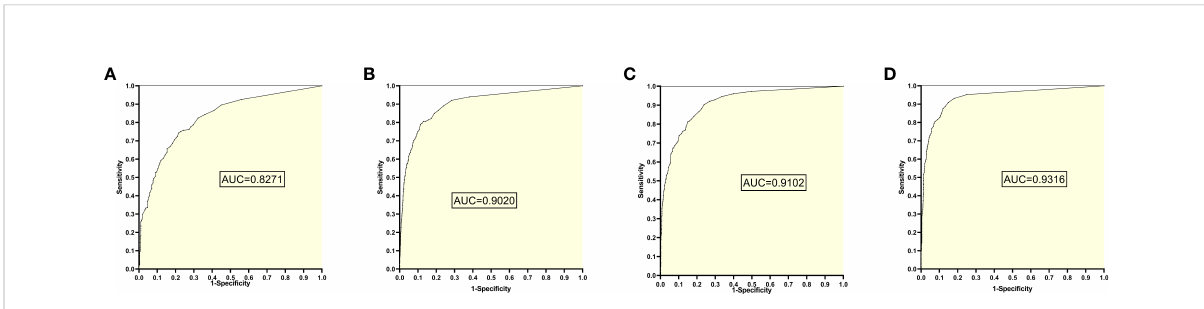
FIGURE 5 ROC curves and AUC values obtained from the training set 4 model testing each test set: (A) results from test set 1; (B) results from test set 2; (C) results from test set 3; (D) results from test set